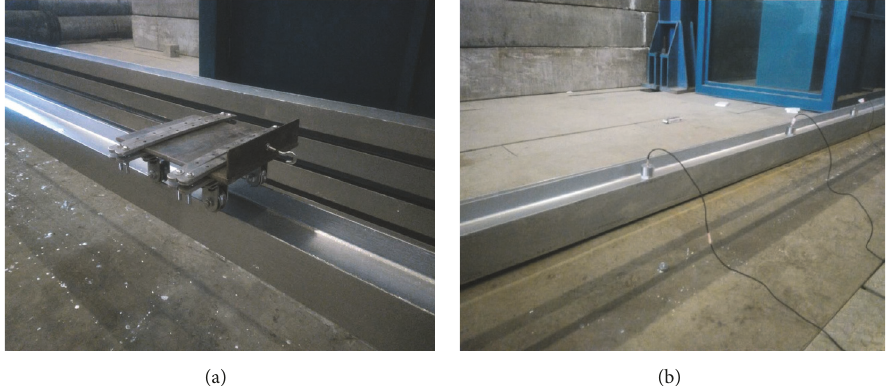
Figure 5: A general view of the vehicle (a) and accelerometers (b).